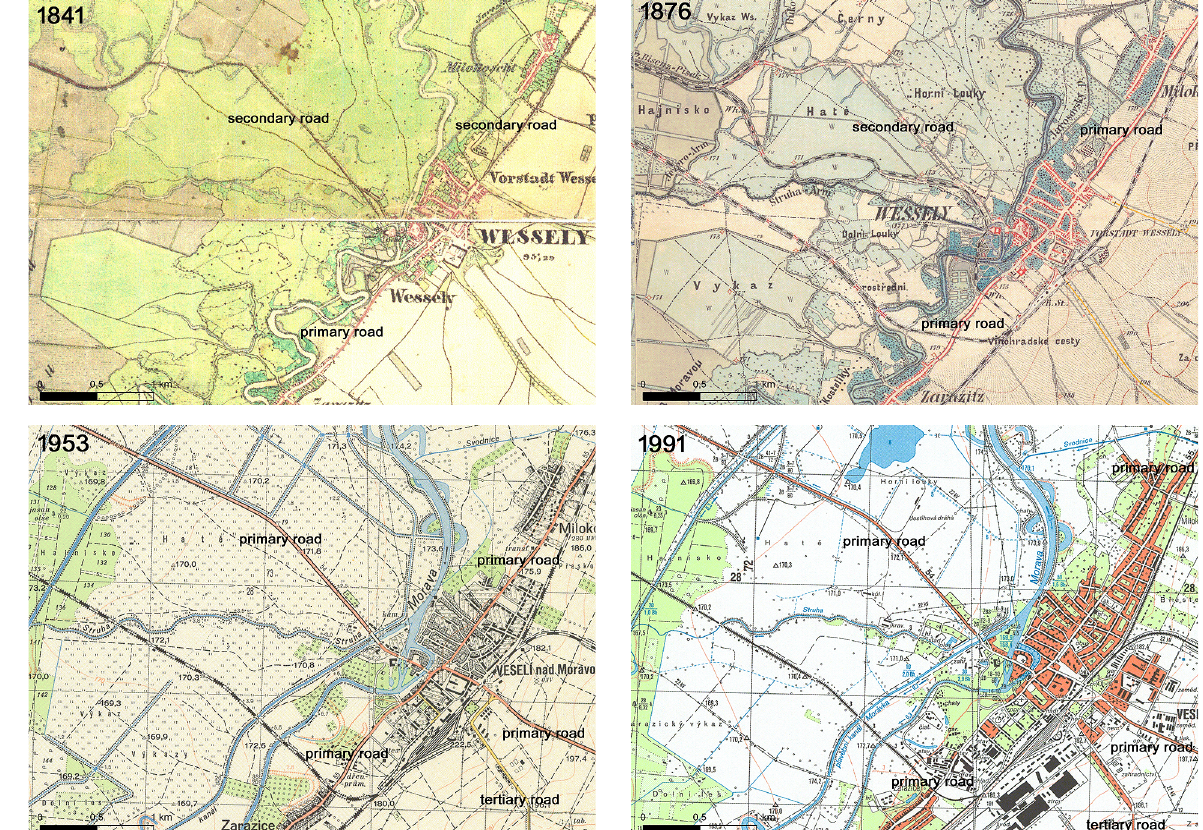
Fig. 2. Examples of the road network around the town of veselí nad Moravou on maps from 1841, 1876, 1953, 1991 with the addition of road classification to the map.